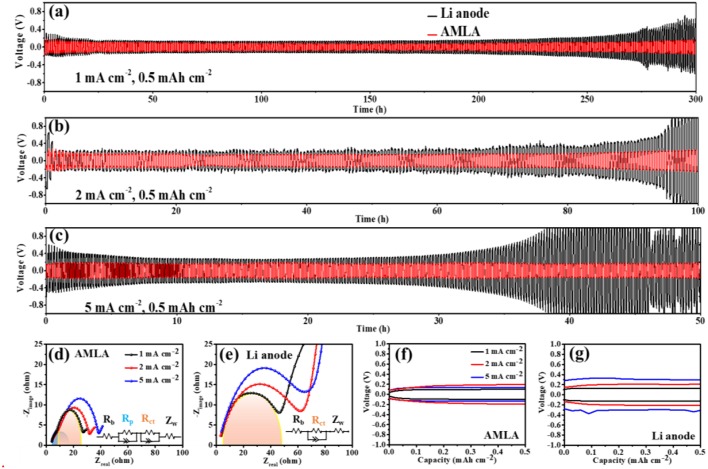
The electrochemical performances of symmetrical cells. (a–c) The voltage-time curves of Li anode (back) and AMLA (red) electrodes under 1, 2, and 5 mA cm−2current density, the deposit amount of Li+ is 0.5 mAh cm−2 for all the battery. The EIS figures of AMLA (d) and Li anode (e) after 30 times' cycles under 1 mA cm−2 (black), 2 mA cm−2 (red), and 5 mA cm−2 (blue) current density. The polarization voltage figures of AMLA (f) and Li anode (g) after 30 times' cycles, under 1 mA cm−2 (black), 2 mA cm−2 (red), and 5 mA cm−2 (blue) current density.